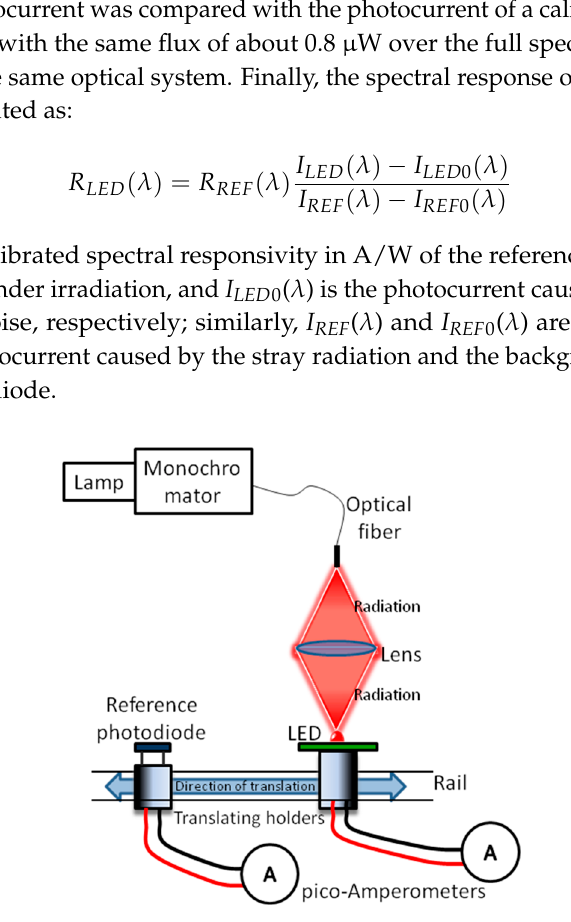
Figure 2. Experimental setup for the detection parameters measurement.